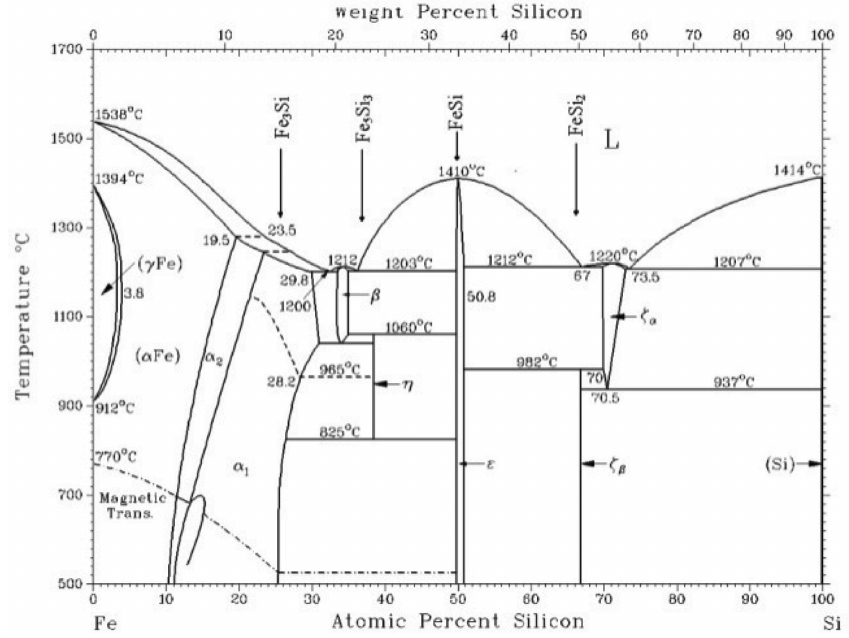
Figure 12: The Fe – Si phase